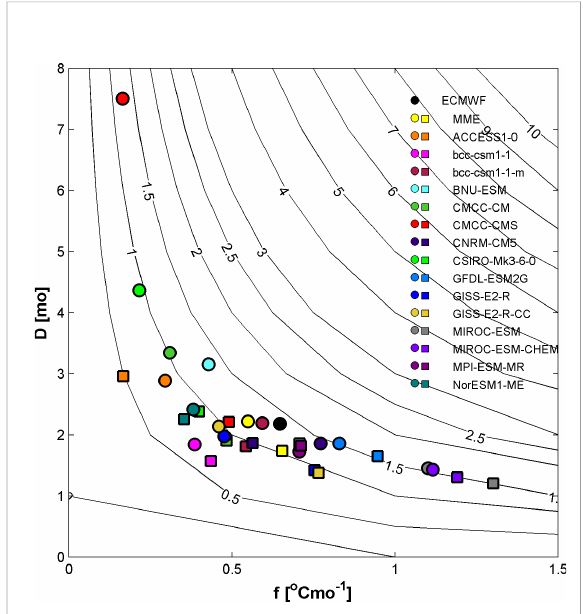
FIGURE 9 Scatterplots of SSTAC amplitudes (°C) as a function of the dynamical response factor D (month) and total external forcing f (°C month -1 ) from ECMWF reanalysis dataset (black circle), MME and each of 15 models in the historical period (colored circles) and RCP4.5 scenario (colored